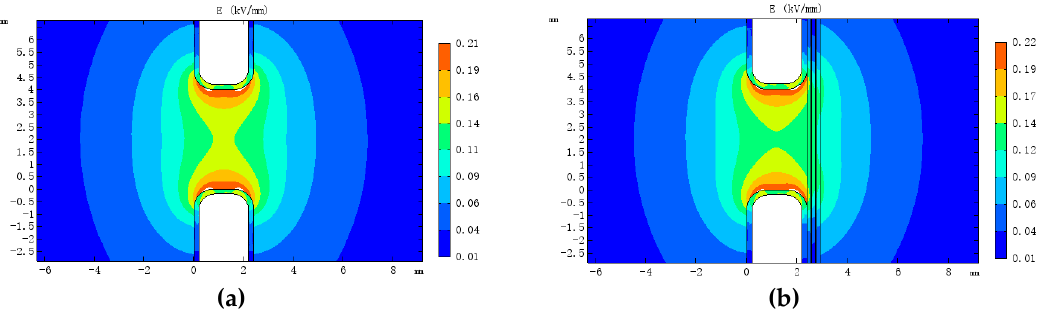
Figure 6. ( a ) Original electric field distribution between cakes and ( b ) electrical field distribution between cakes after installation of optical